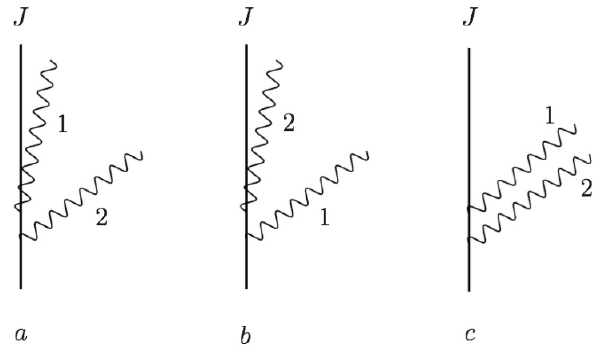
Figure 9 . Con(cid:12)gurations of collinear-soft emissions at NNLO. Either emissions 1 or 2 are closest to the eikonal direction J ( a , b ) or 1 & 2 get clustered into one branch (cid:12)rst and are then combined with J ( c